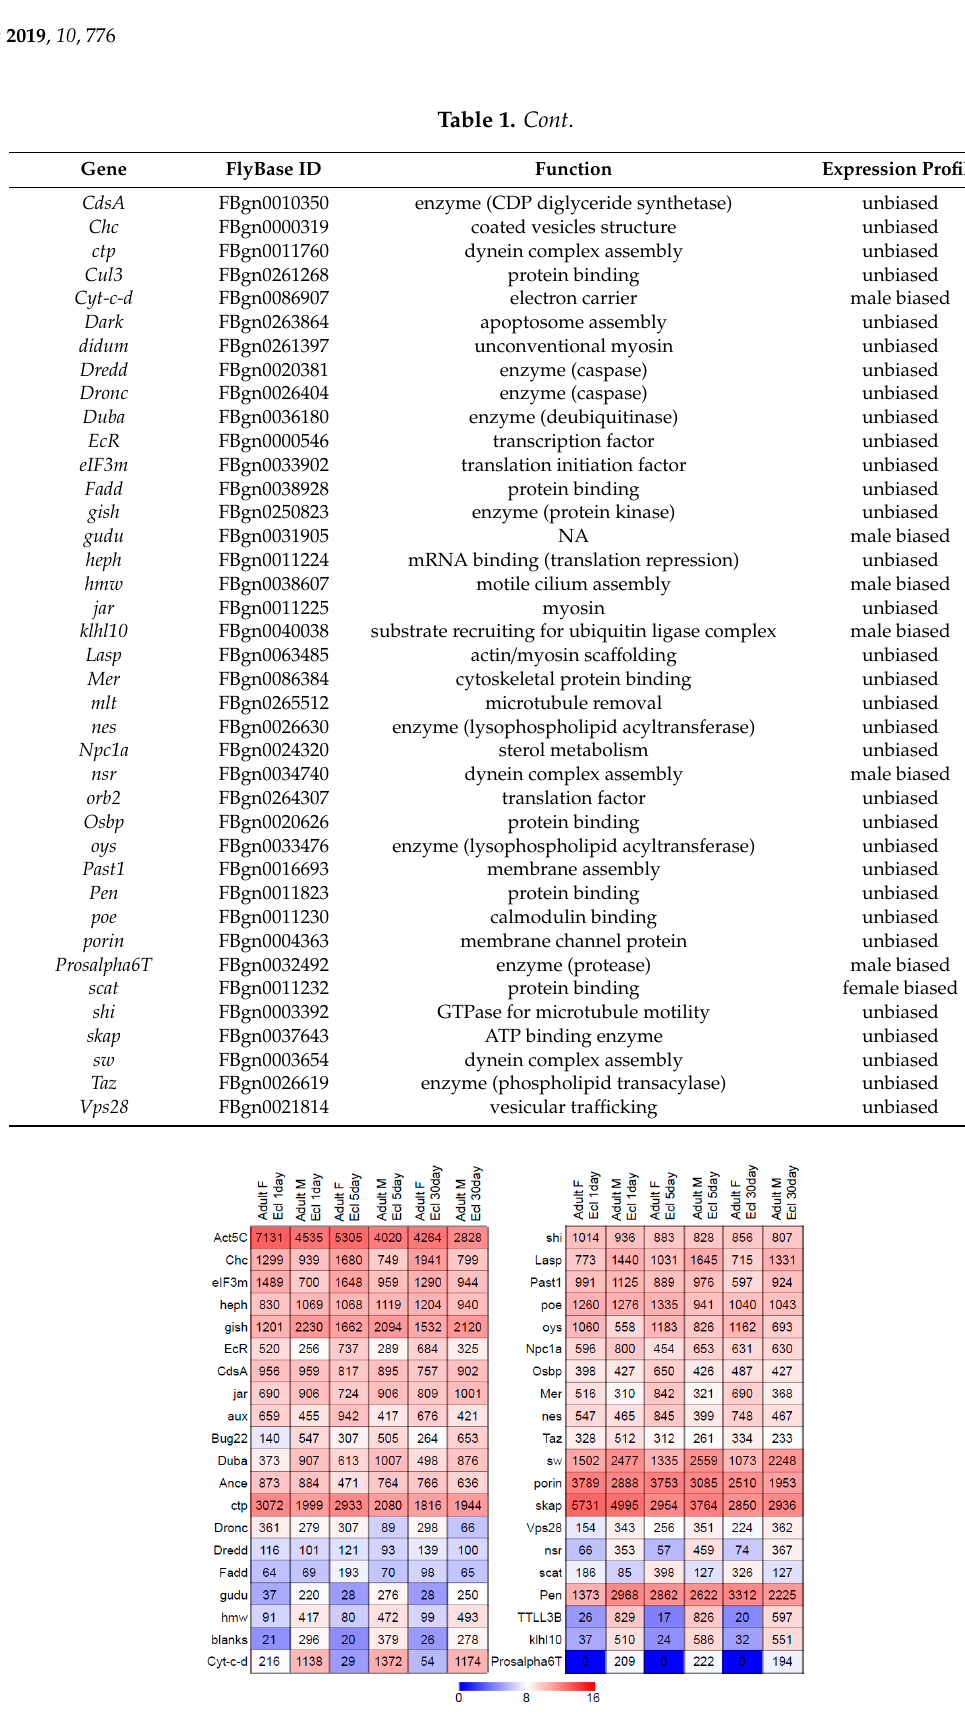
Figure 1. Heatmap visualization of gene expression scores (log 2 of the actual value) of sperm individualization genes in Drosophila melanogaster as derived from RNA-seq data from different stages of adult male and female flies [27].